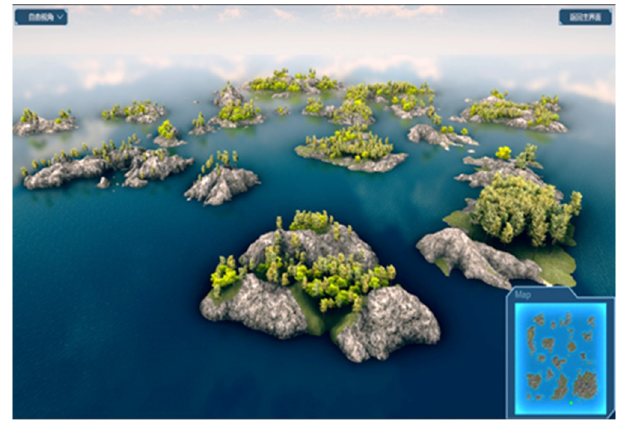
Figure 9. High fidelity water environment.